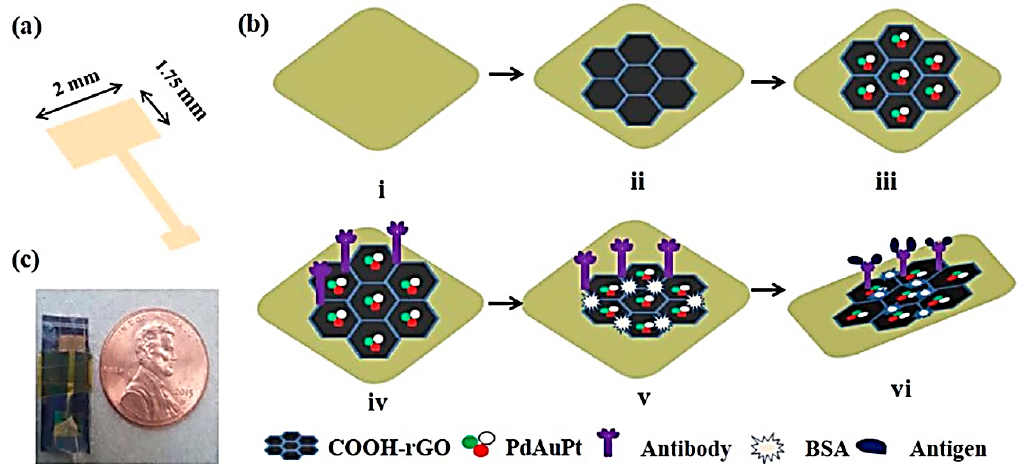
Figure 11. Schematic illustrations of the ( a ) sensing platform, ( b ) preparation sequence of trimetallic PdAuPt / COOH-rGO immuno-sensor for the CEA / PSA detection; photomicrograph of the ( c ) advanced immunosensors. Reproduced from [119], with permission from Elsevier, 2018.